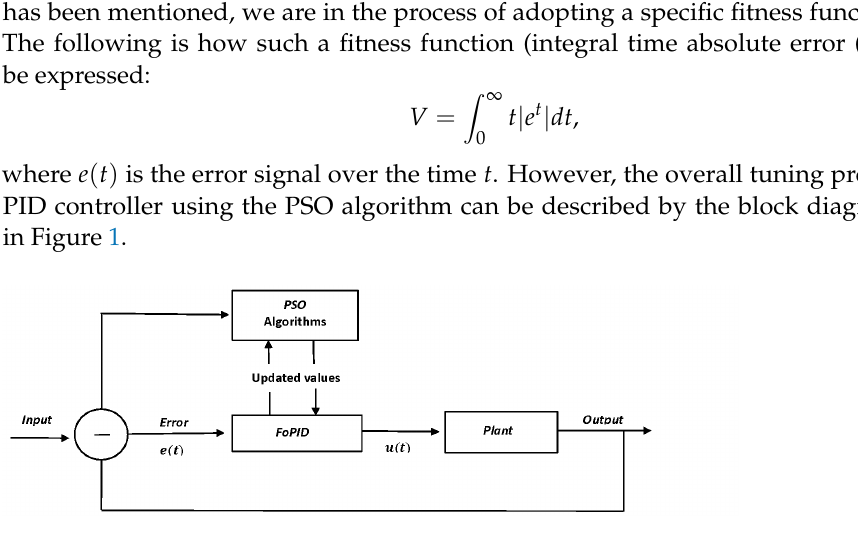
Figure 1. Block diagram of the PSO algorithm running to tune the PI γ D ρ